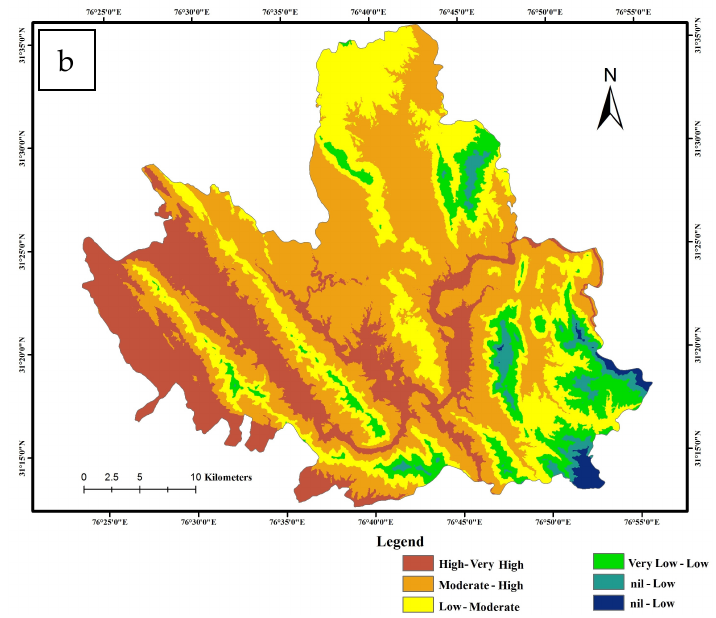
Figure 9. ( a ) Contour map of Bilaspur district; ( b ) Elevation index map of Bilaspur district.